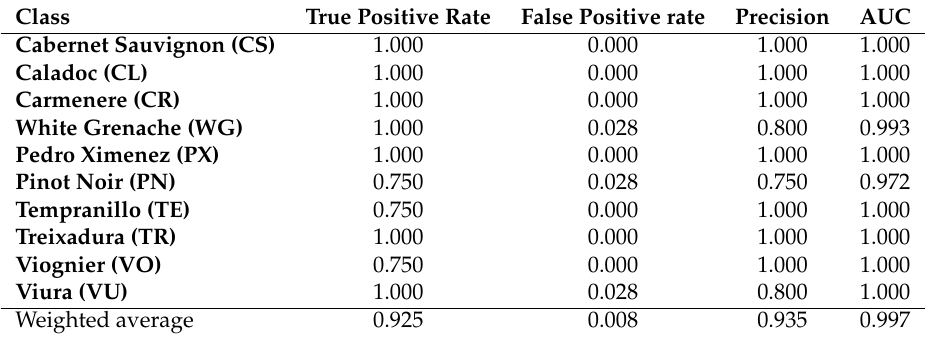
Table 4. Detailed accuracy by class of the grapevine varietal classification using support vector machines and an external validation of 40 samples (n =